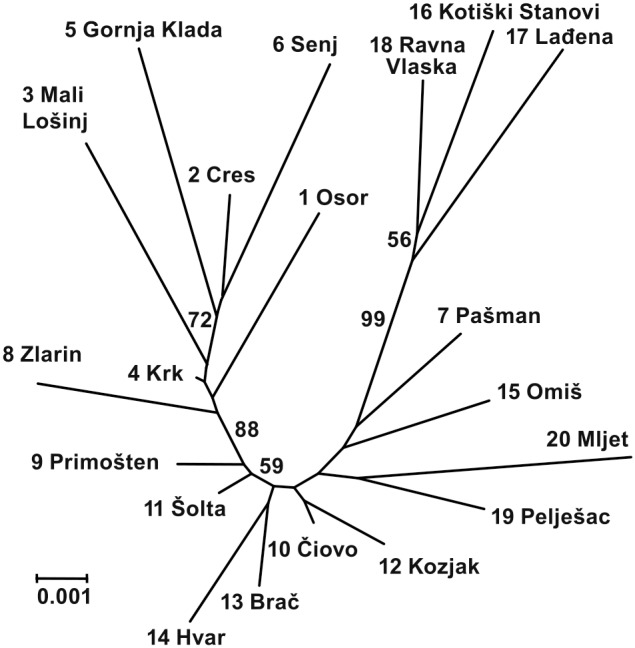
Unrooted Fitch-Margoliash tree of 20 Tanacetum cinerariifolium populations.Bootstrap values greater than 50% that were obtained after 1000 permutations are indicated on the branches.